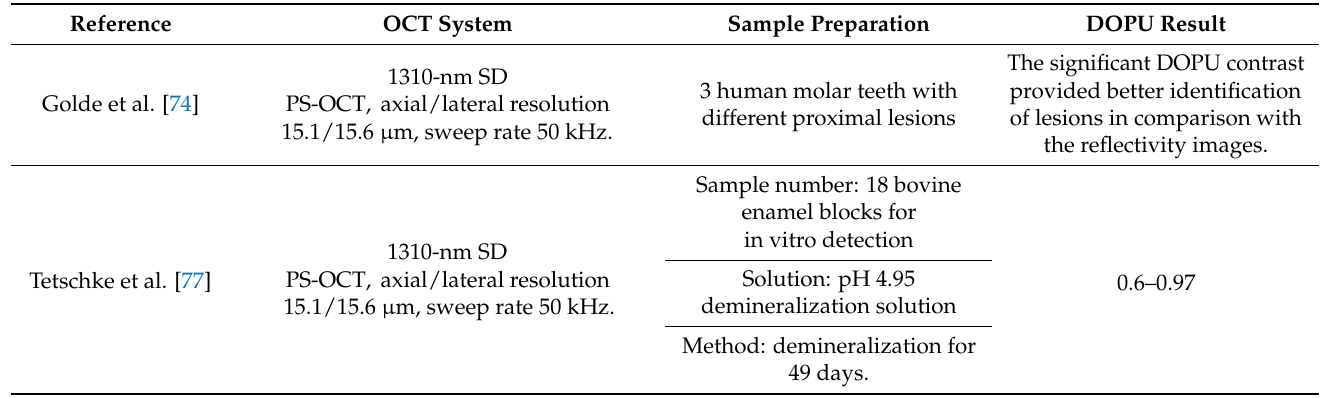
Table 4. Results of quantifying enamel caries with degree of